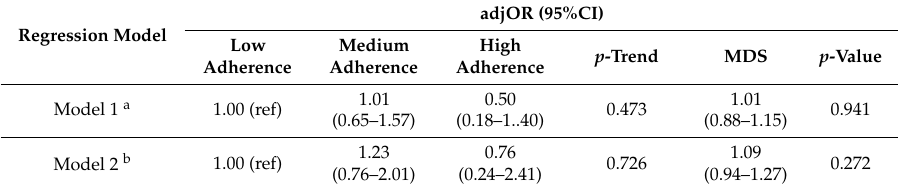
Table 7. Association between adherence to Mediterranean diet and the risk of